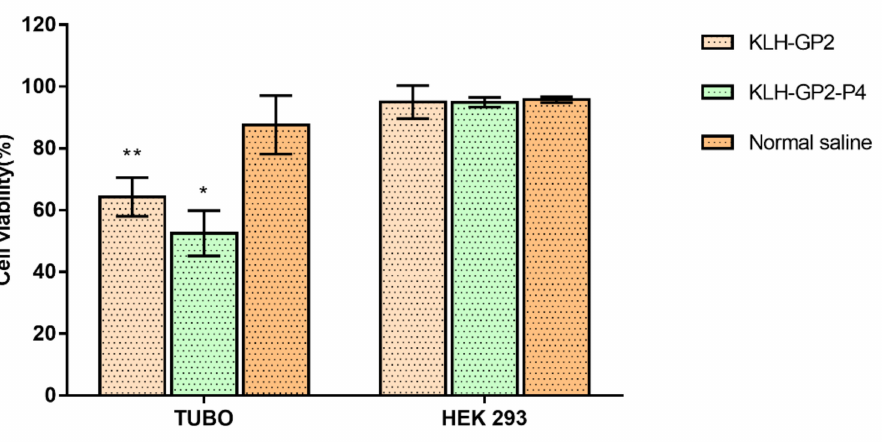
Figure 3. The cell viability of TUBO and HEK293 cells following treatment with sera from the immunized mice. All values are expressed as mean ( n = 3) ± SEM. The comparison between treated (normal saline, KLH–GP2 and KLH–GP2–P4) and untreated cells (vehicle control group) was evaluated using one-way ANOVA followed by Dunnett’s multiple comparison test (* p < 0.05 and ** p < 0.01).